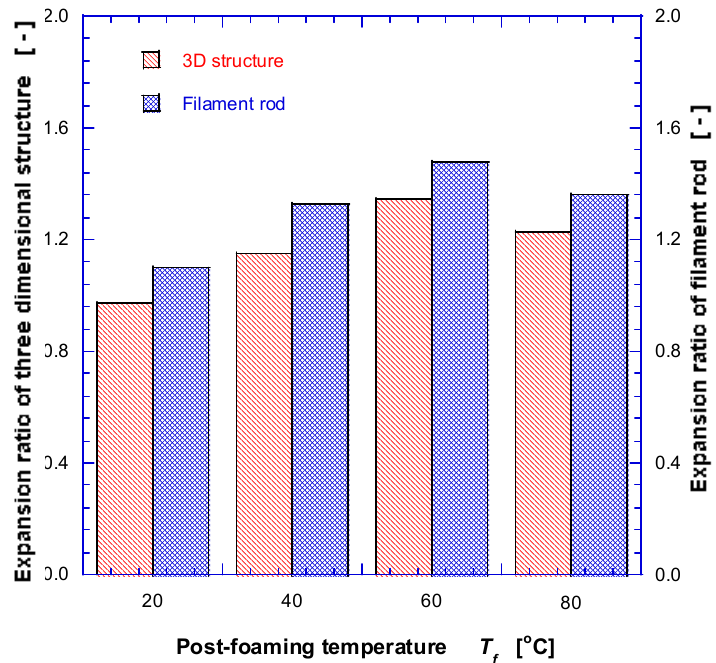
Figure 4. Measured expansion ratios for fabricated 3D structures and free rod at various post-foaming temperatures of PLA ( 𝑃 𝑠 = 10 MPa, 𝑇 𝑠 = − 20 °C ).